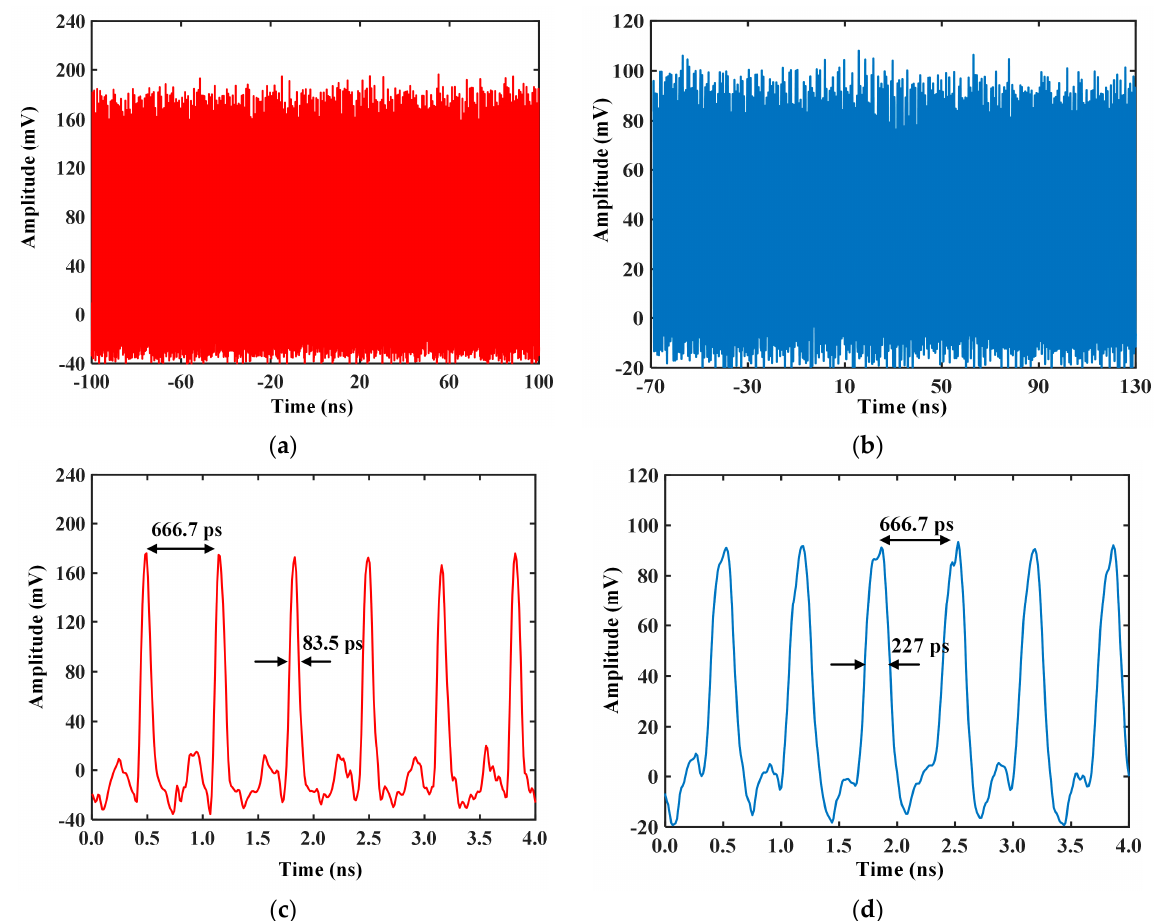
Figure 5. The measured optical pulse train by a real-time oscilloscope. ( a ) The measured pulse train after the MZM with a recording time of 200 ns; ( b ) The measured broadened pulse train before the PD with a recording time of 200 ns; ( c ) The measured pulse train after the MZM with the recording time range from 0 to 4 ns; ( d ) The measured broadened pulse train before the PD with the recording time range from 0 to 4 ns.